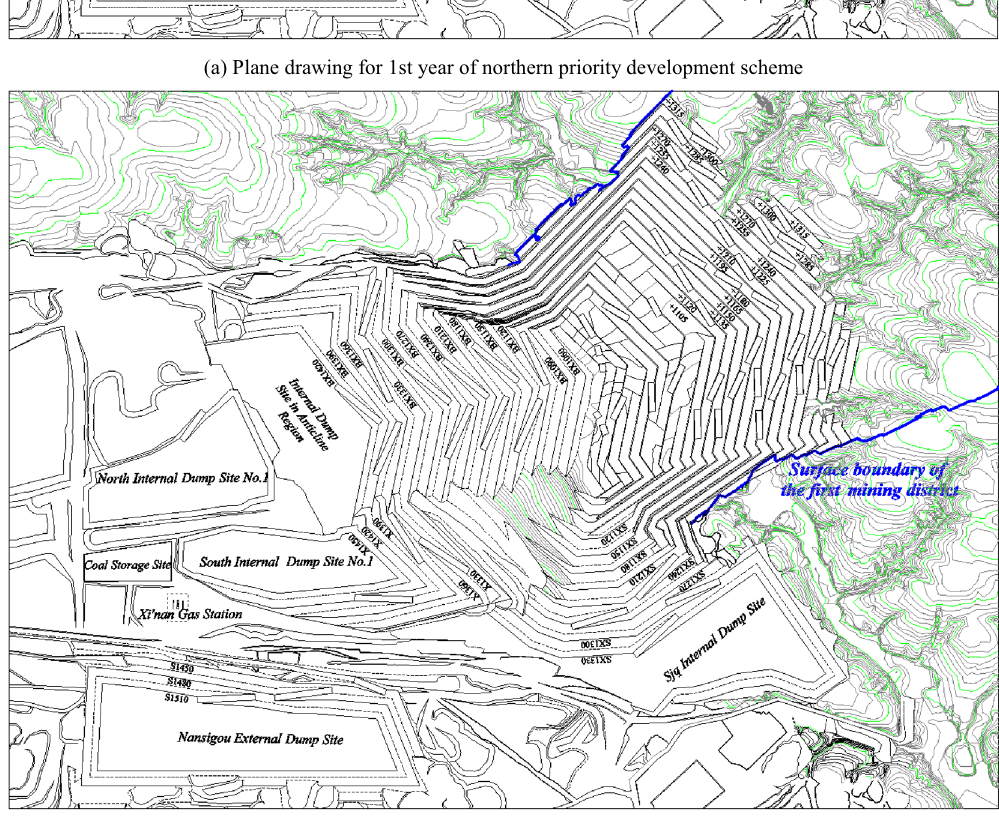
Fig. 17 Plane drawings of mining and dumping plan of northern priority development